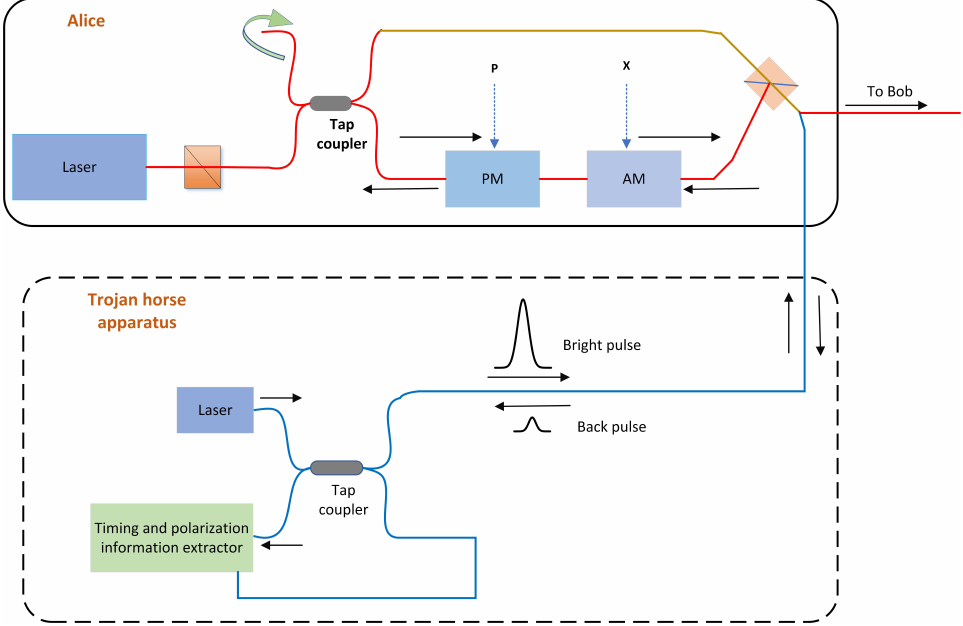
Figure 1. Schematic diagram of Trojan horse attacks. PM, phase modulation; AM, amplitude modulation; BS, beam